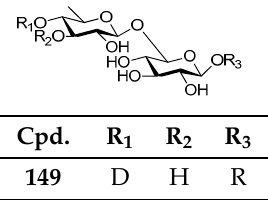
Figure 14. Structure of compound 149 .